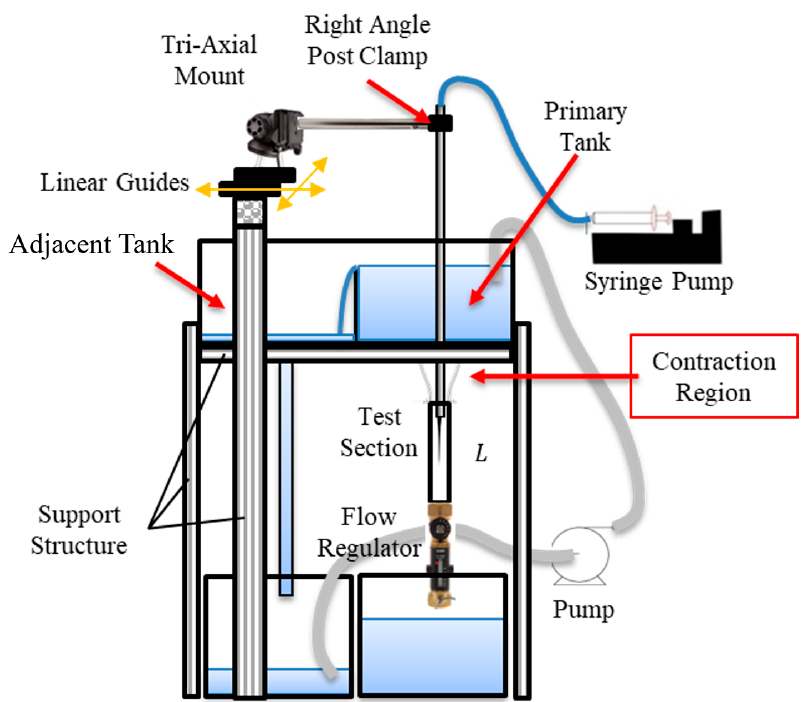
Figure 4. Schematic of in vitro experiments with the contraction section, dye centering apparatus, and partitioning wall to maintain constant water level.